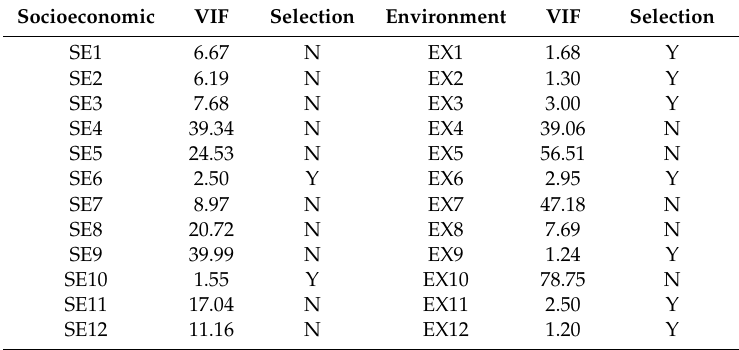
Table A2. Multicollinearity evaluation for the socioeconomic (SE1–SE20) and environmental (EX1–EX12)